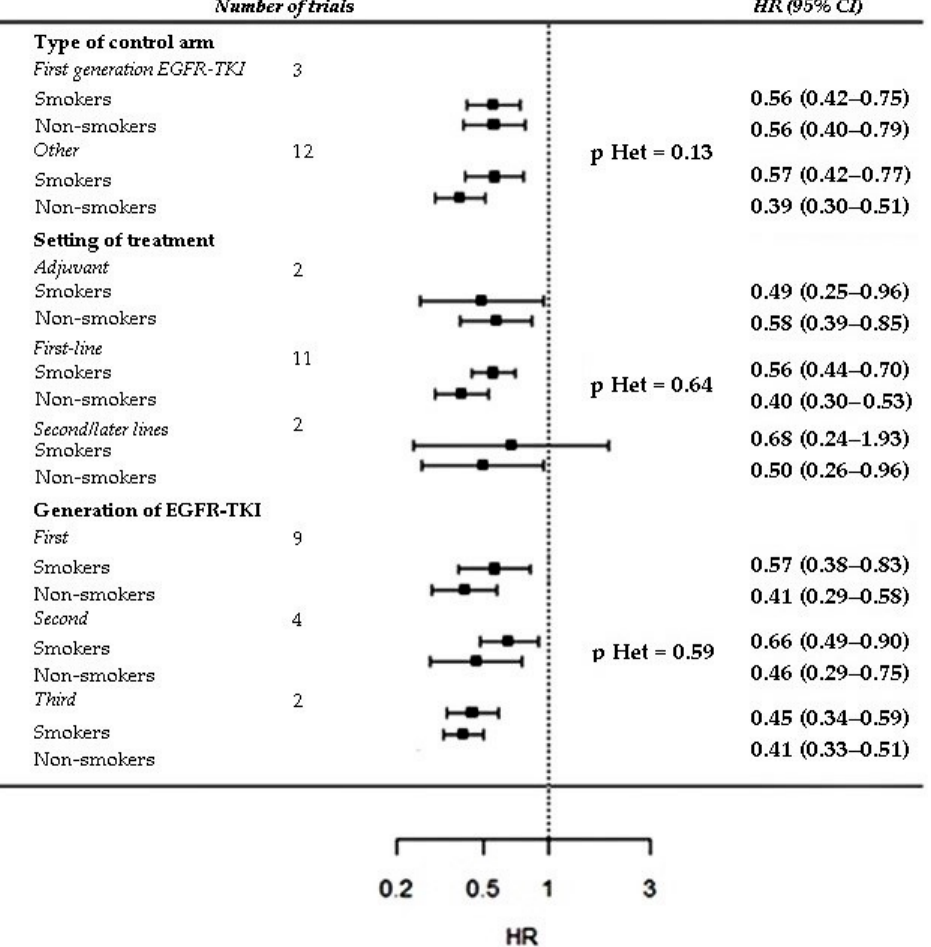
Figure 8. Subgroup analysis of PFS interaction with smoking status. Trials are grouped according to type of control arm (first-generation EGFR-TKI vs. other), setting / line of treatment (adjuvant vs. first line vs. other) and generation of the EGFR-TKI tested in the experimental arm (first vs. second vs. third). p value for heterogeneity ( p Het) among pooled ratios of the PFS-HRs in smokers vs. non-smokers computed in trial subgroups is provided.